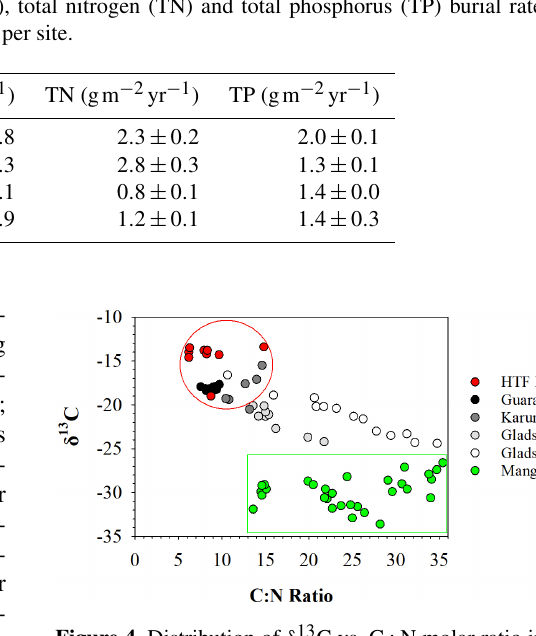
Figure 4. Distribution of δ 13 C vs. C : N molar ratio in the four hy- persaline tidal flat sediment cores. Endmember values were taken from HTF surface microphytobenthos and nearby mangrove vege-